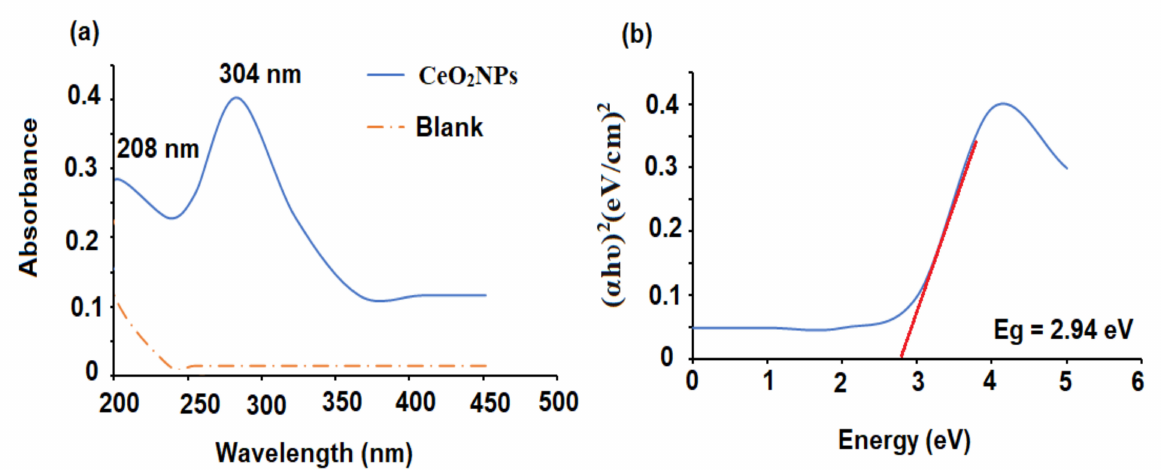
Figure 1. ( a ) UV-Vis spectrum of CeO 2 NPs against deionized water as blank and ( b ) calculated bandgap energy of the biogenic CeO 2